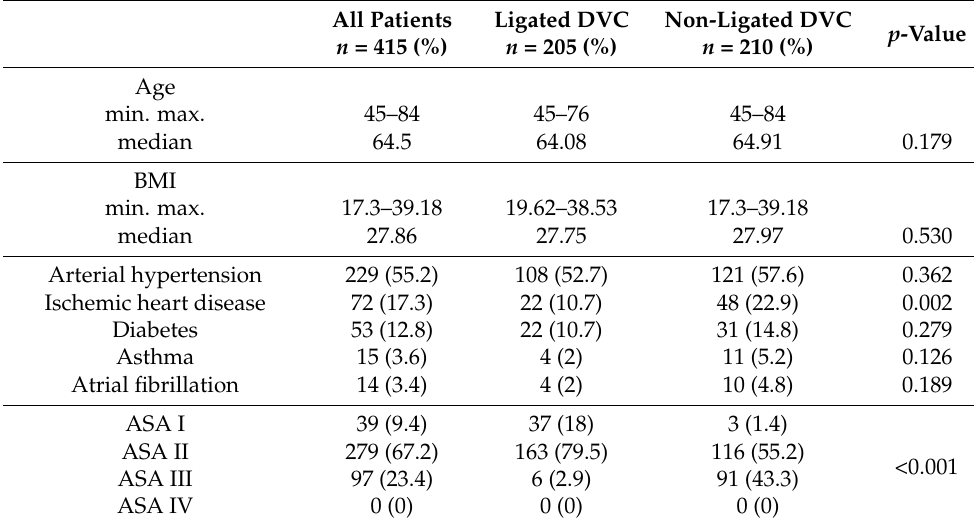
Table 2. Characteristics of